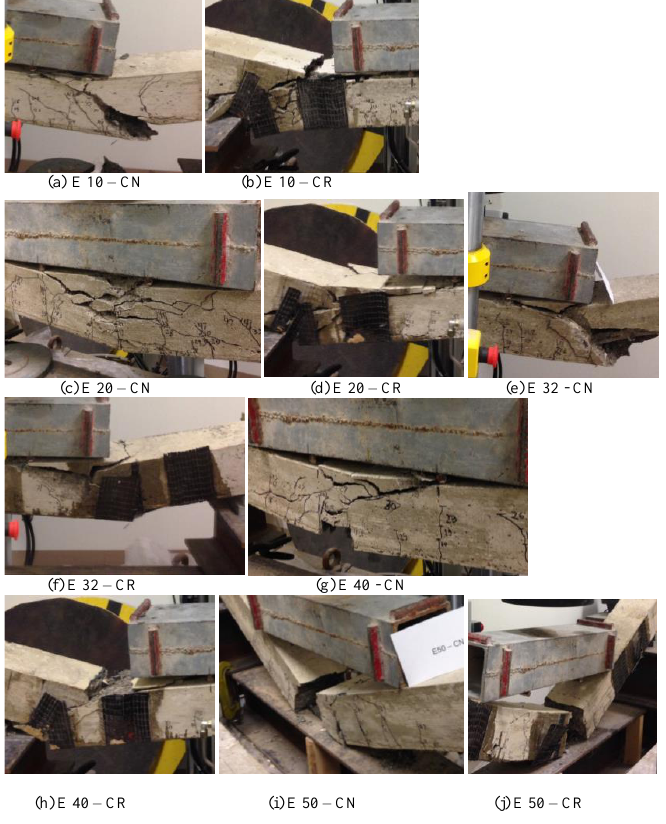
Figure 13. Failure of beams with experimental corrosion. Table 8. Failure description of beams with experimental corrosion.